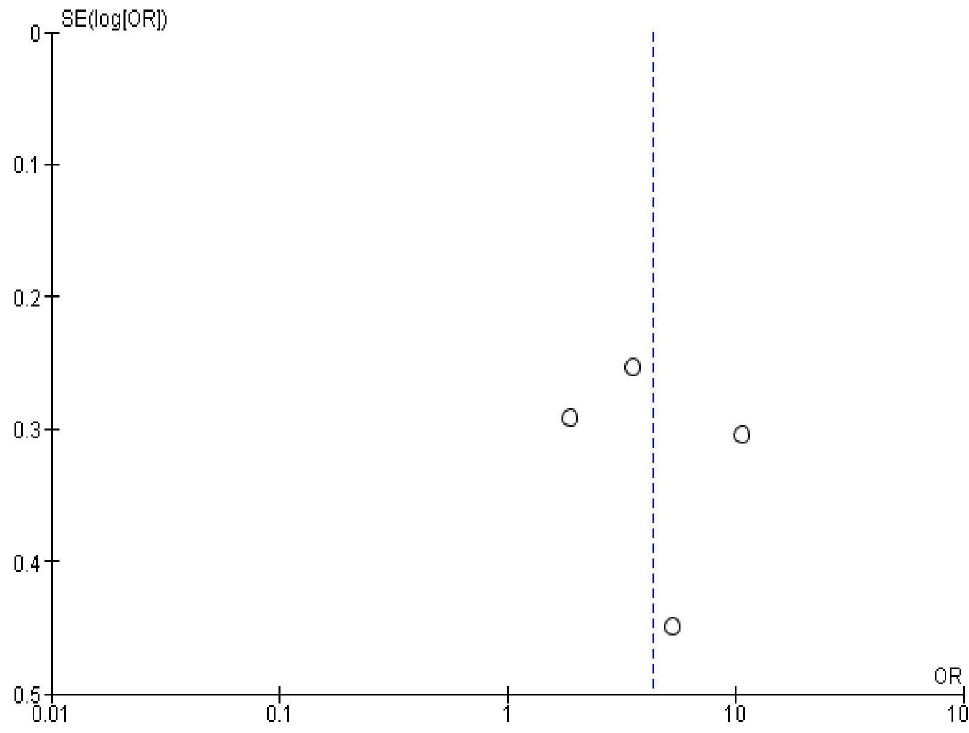
Fig 14. Publication bias on marital status.